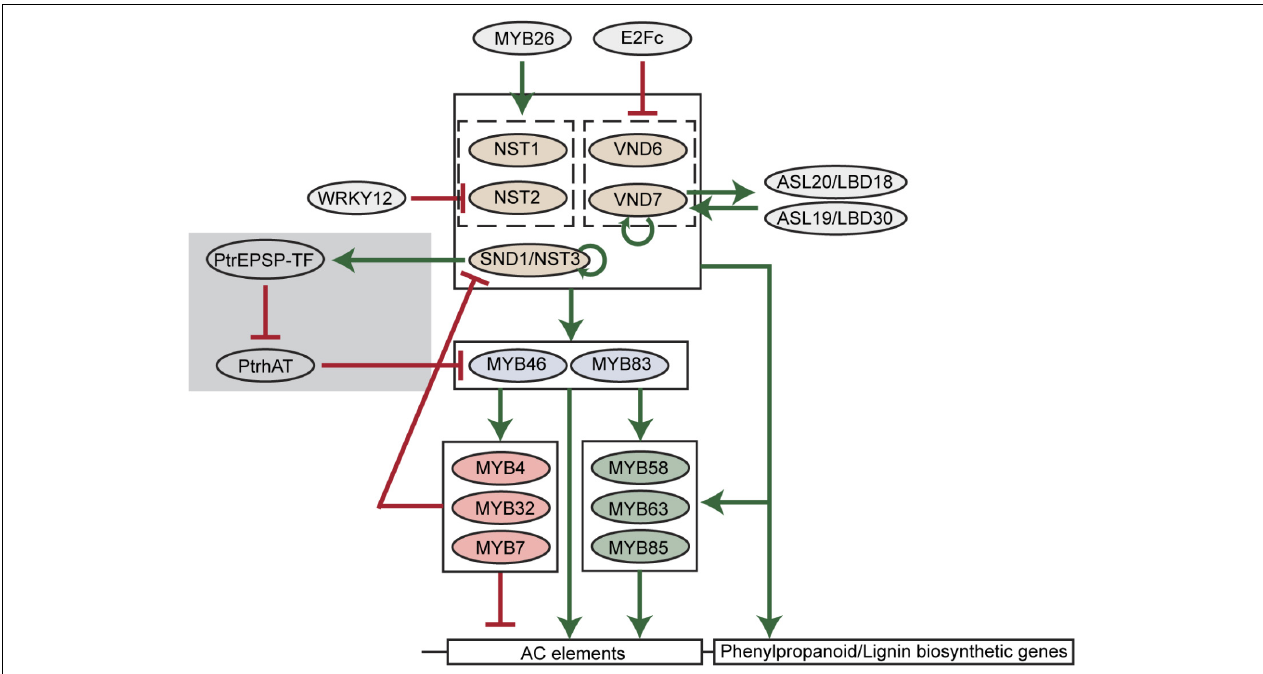
FIGURE 2 | A scheme of transcriptional regulation of lignin biosynthetic genes in plants. Green arrows indicate transcriptional activation. Red blunt arrows indicate transcriptional repression. The gray shade indicates the woody plant-specific regulatory